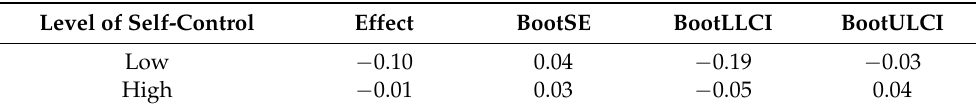
Table 4. Total, individual, and serial indirect effects for self-control on cyberbullying behavior and bias-corrected 95% confidence